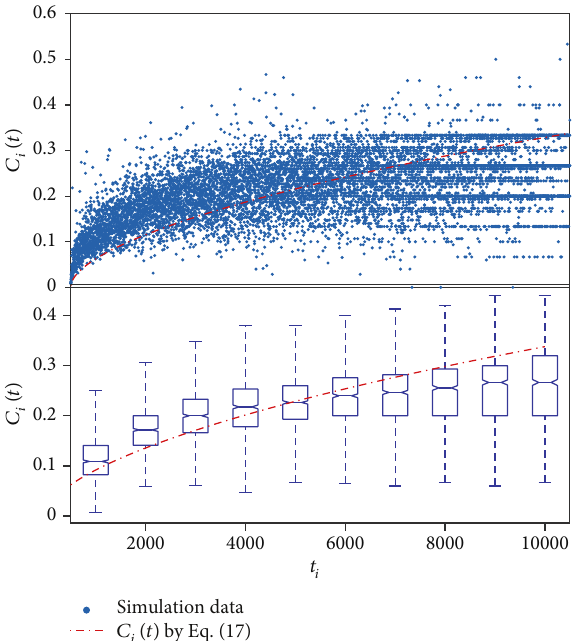
ð t Þ as a function of t i i . Simulation data is averaged from 1000 networks (